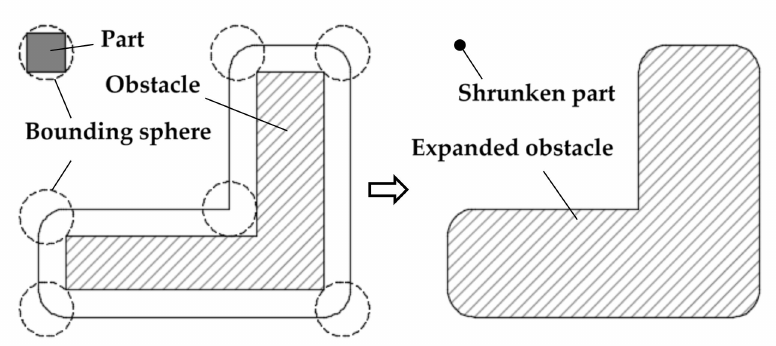
Figure 2. A part before and after shrinking, and an obstacle before and after